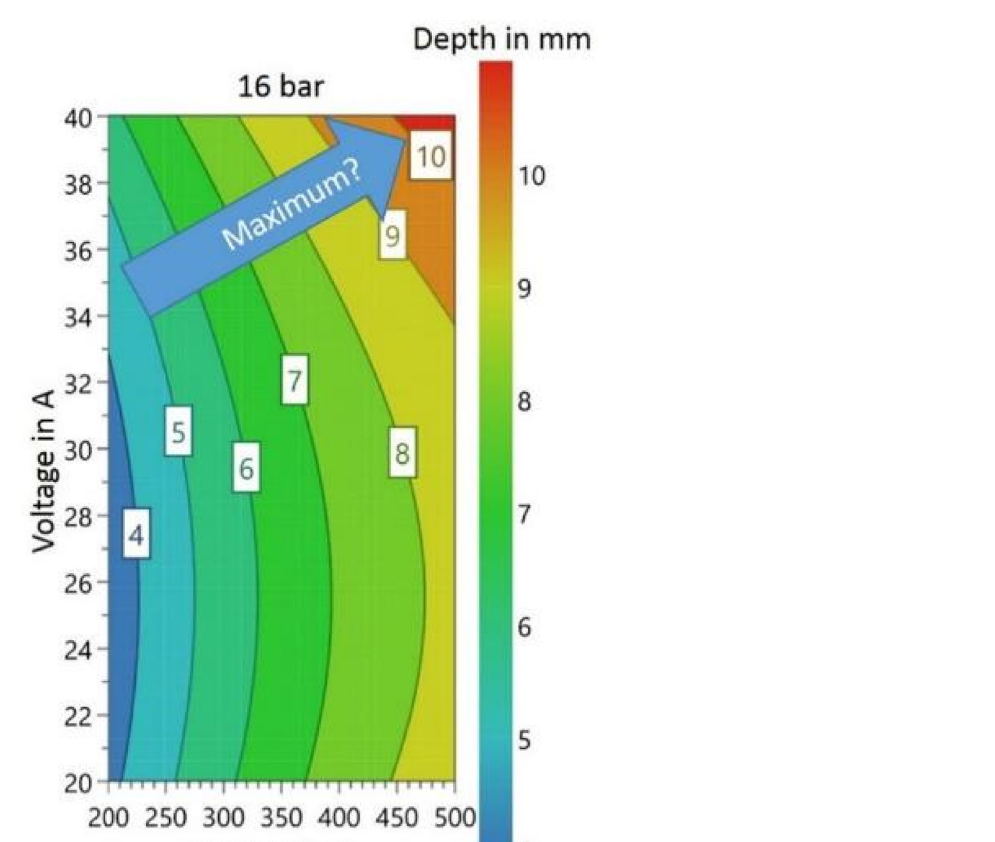
Figure 6. Statistical model for the weld penetration for bead on plate welds.